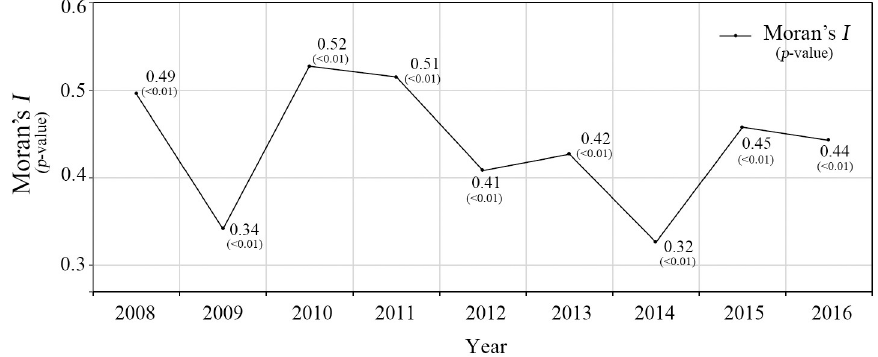
Fig 2. Spatial autocorrelation of TB incidence rate